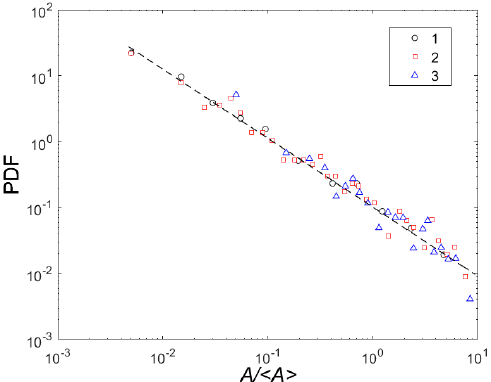
Figure 5. PDF dependences for local strain-rate fluctuations before the onset of the Portevin–Le Chatelier (PLC) instability: 1—Macroscopically elastic part, β = 1.04 ± 0.05. 2—Elastoplastic transition, β = 0.98 ± 0.04. 3—The totality of data for ε < ε cr , β = 1.06 ± 0.04.